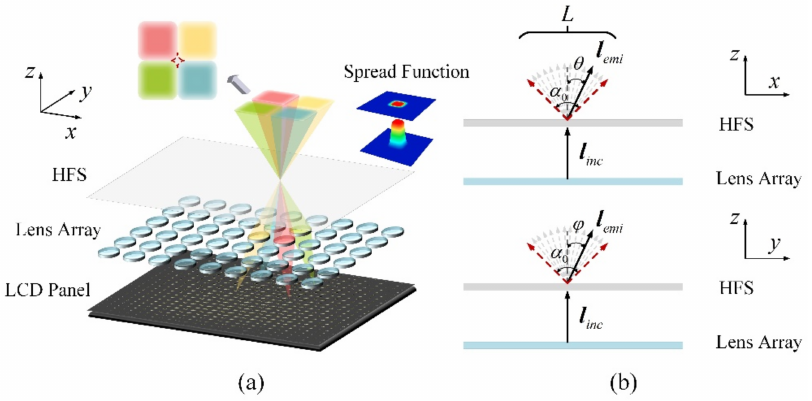
Figure 8. ( a ) Schematic of the 3D LFD system based on the HFS with the proposed spread function, and ( b ) cross-sectional views of the light diffusing